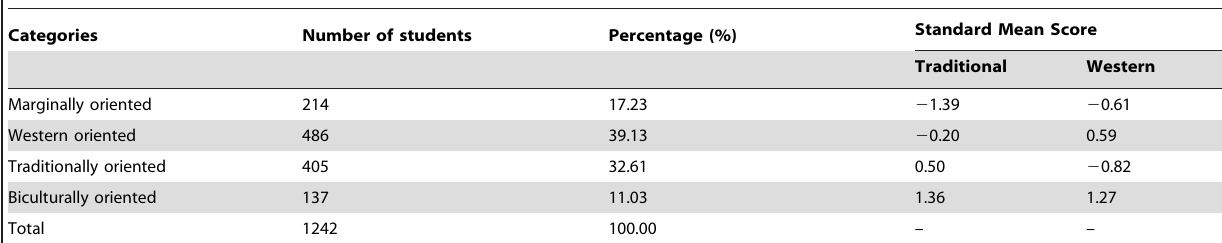
Table 1. The four categories in cultural orientations (N